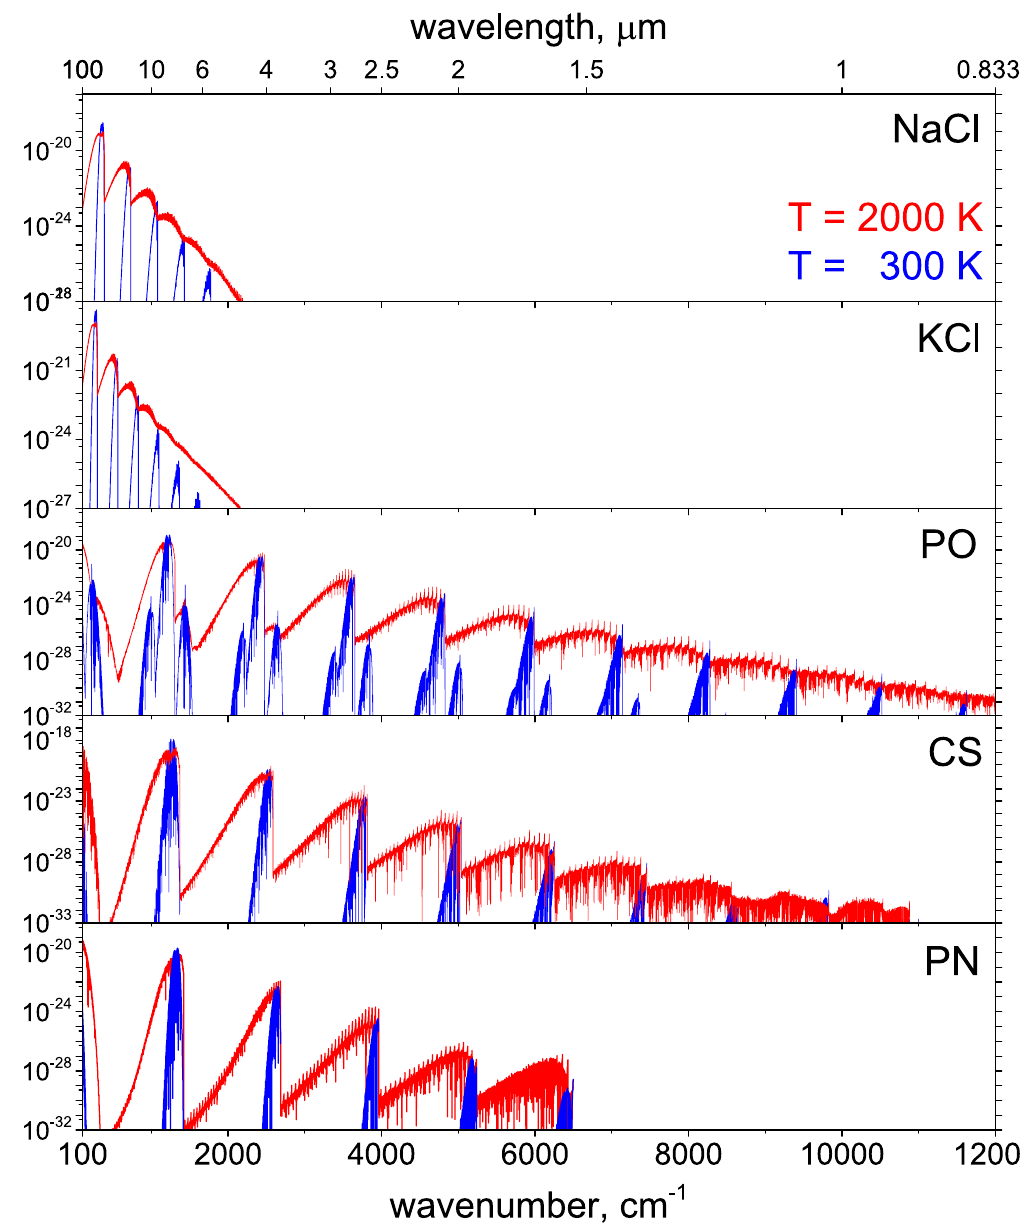
Figure 9. Cross sections generated from ExoMol line lists for sodium chloride [54], potassium chloride [54], phosphorous monoxide [71], carbon monosulfide [61] and phosphorous nitride